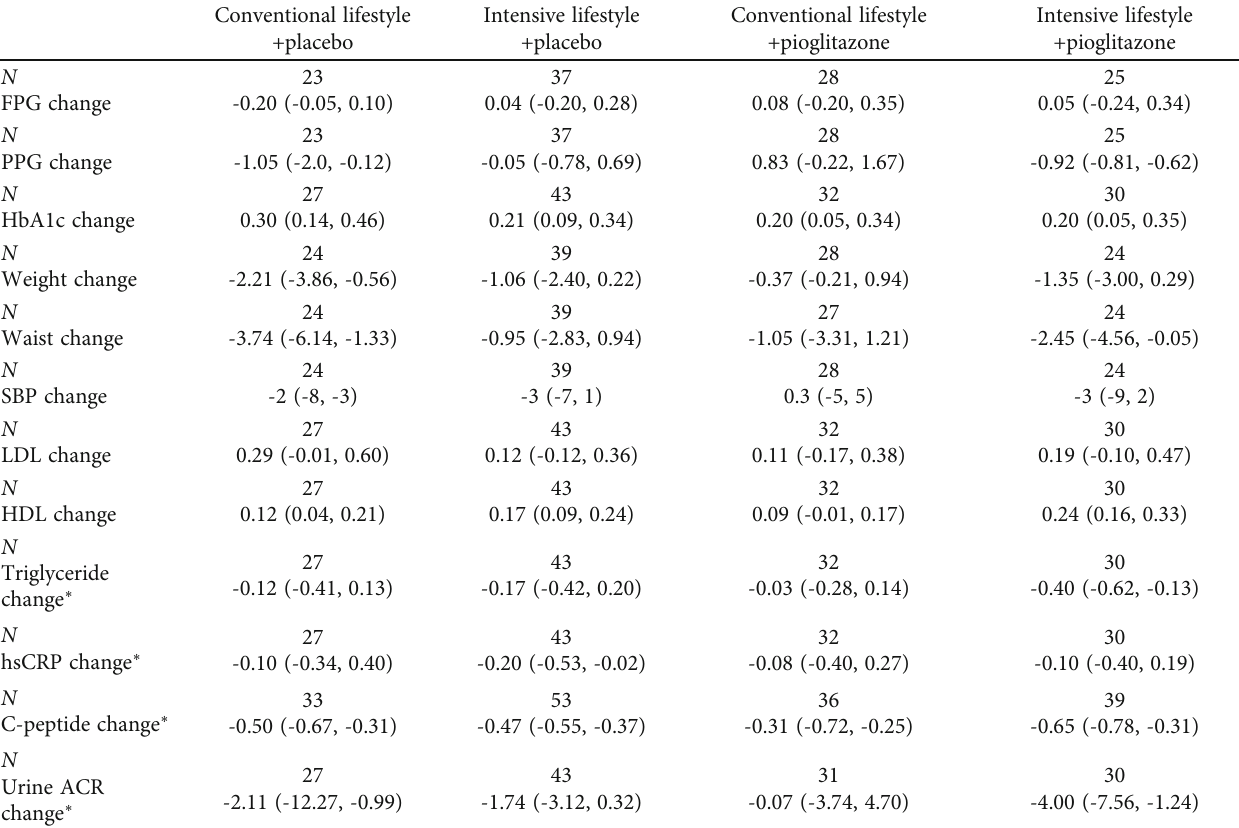
Table 3: Mean change (95% CI) or median change (95% CI of median) ∗ in the levels of secondary study parameters at 3 years of follow-up in the 4 treatment groups. The analysis is based on intention-to-treat